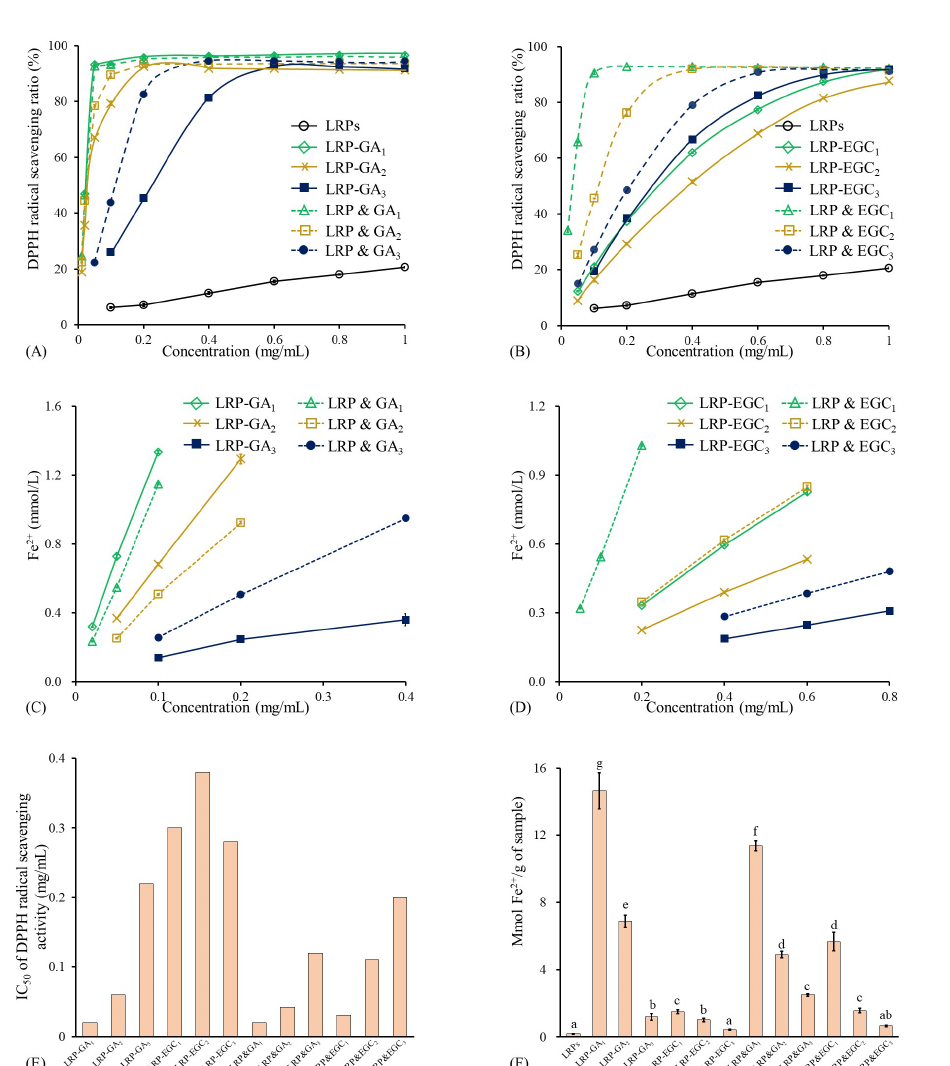
Figure 7. Antioxidant activities of LRPs, LRP-phenol complexes, and their physical mixtures. ( A ) DPPH radical scavenging ratio of LRPs, LRP-GA complexes, and their physical mixtures at different concentrations; ( B ) DPPH radical scavenging ratio of LRPs, LRP-EGC complexes, and their physical mixtures at different concentrations; ( C ) FRAP activities of LRPs, LRP-GA complexes, and their physical mixtures at different concentrations; ( D ) FRAP activities of LRPs, LRP-EGC complexes, and their physical mixtures at different concentrations. ( E ) IC 50 values for DPPH radical scavenging activity of LRP-phenol complexes and their physical mixtures; ( F ) FRAP activities of LRPs, LRP- phenol complexes, and their physical mixtures expressed as mmol Fe 2 + /g sample. Means of the samples with different letters (a–g) differ significantly ( p